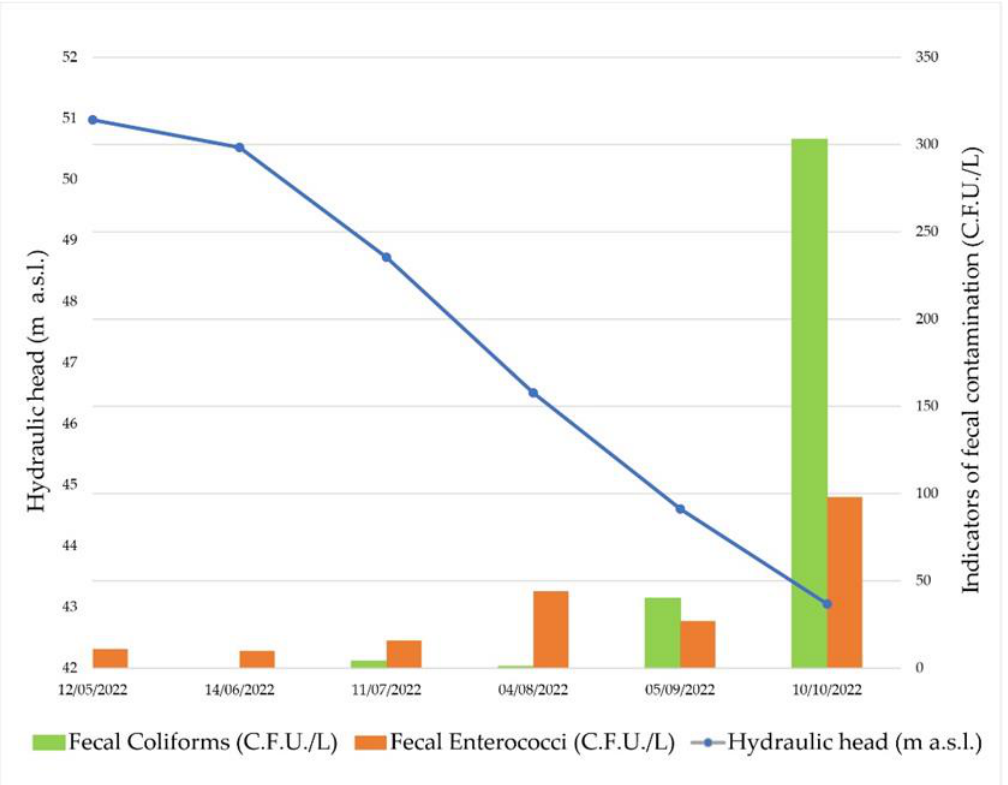
Figure 10. Indicators of fecal contamination (C.F.U./L) in the function of the hydraulic head varia- tion in Pz3 (dates are given in day/month/year). in Pz3 (dates are given in